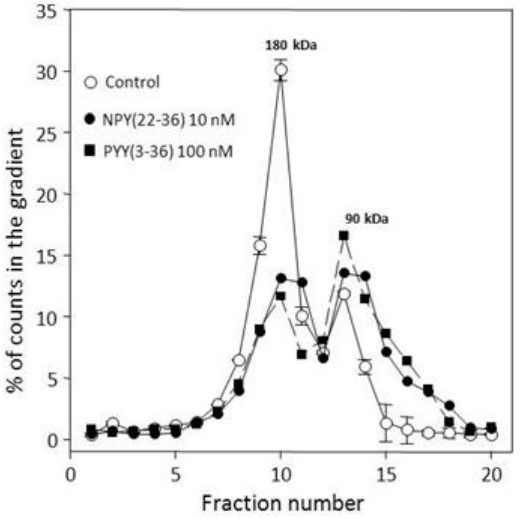
Figure 4. Reduction of Y2 receptors dimers by two agonists of the Y2 receptor. N PY(22-36) (K vs . [ 125 I ]PYY(3-36) at hY2 receptor 6.2 ± 1.2 nM) was used at 10 nM, diss at hY2 receptor 0.50 ± 0.06 nM) at 100 nM final, for 45 min at 25 °C and PYY(3-36) (K diss prior to resedimentation and labeling with 50 pM [ 125 I ]PYY(3-36). After lysis at 10 mM each of digitonin and cholate, duplicate 5%–20% gradients for each condition were centrifuged for 18 h at 5 °C. All results are average percentages of total counts in the corresponding gradient fractions. The standard errors were in most cases below 10%, and for clarity are shown only for the control profile. The content of dimer, in % total gradient counts, was 67.7 ± 4.8 for control gradients, 42.7 ± 2.3 after pre-treatment with 10